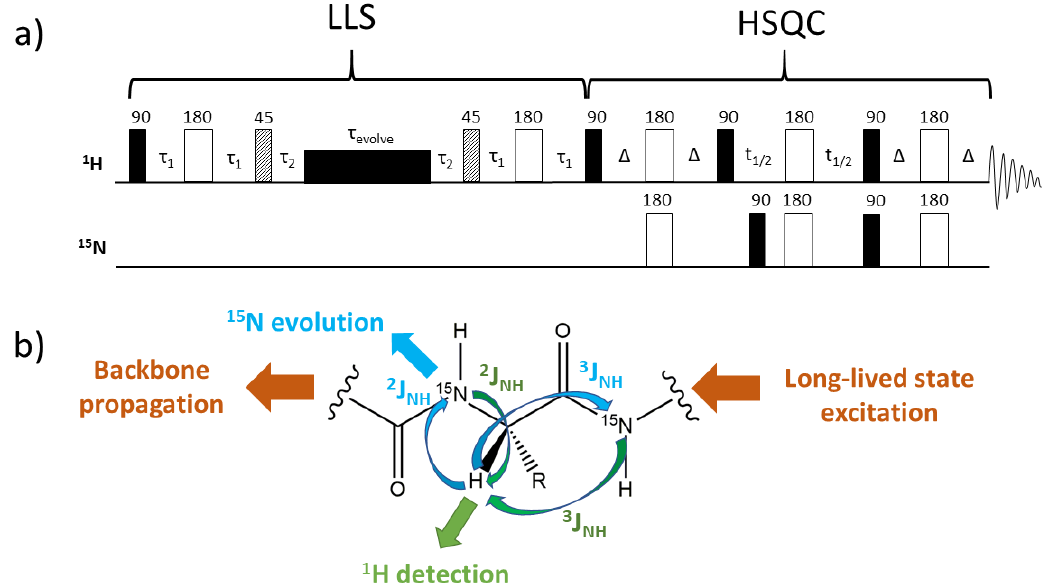
Figure 4. (a) Pulse sequence designed to generate a two-dimensional correlation spectrum between 1 H and 15 N via scalar coupling of the type 2 J NH and 3 J NH starting from a proton long-lived state. (b) Schematic representation of polarisation transfer along a protein’s backbone which generates a two-dimensional correlation spectrum via the 2 J NH and 3 J NH coupling constants. Protons are excited via the first part of the pulse sequence from (a) into a long-lived state spin order. Figure adapted from the reference Fernandes et al. (2013a).